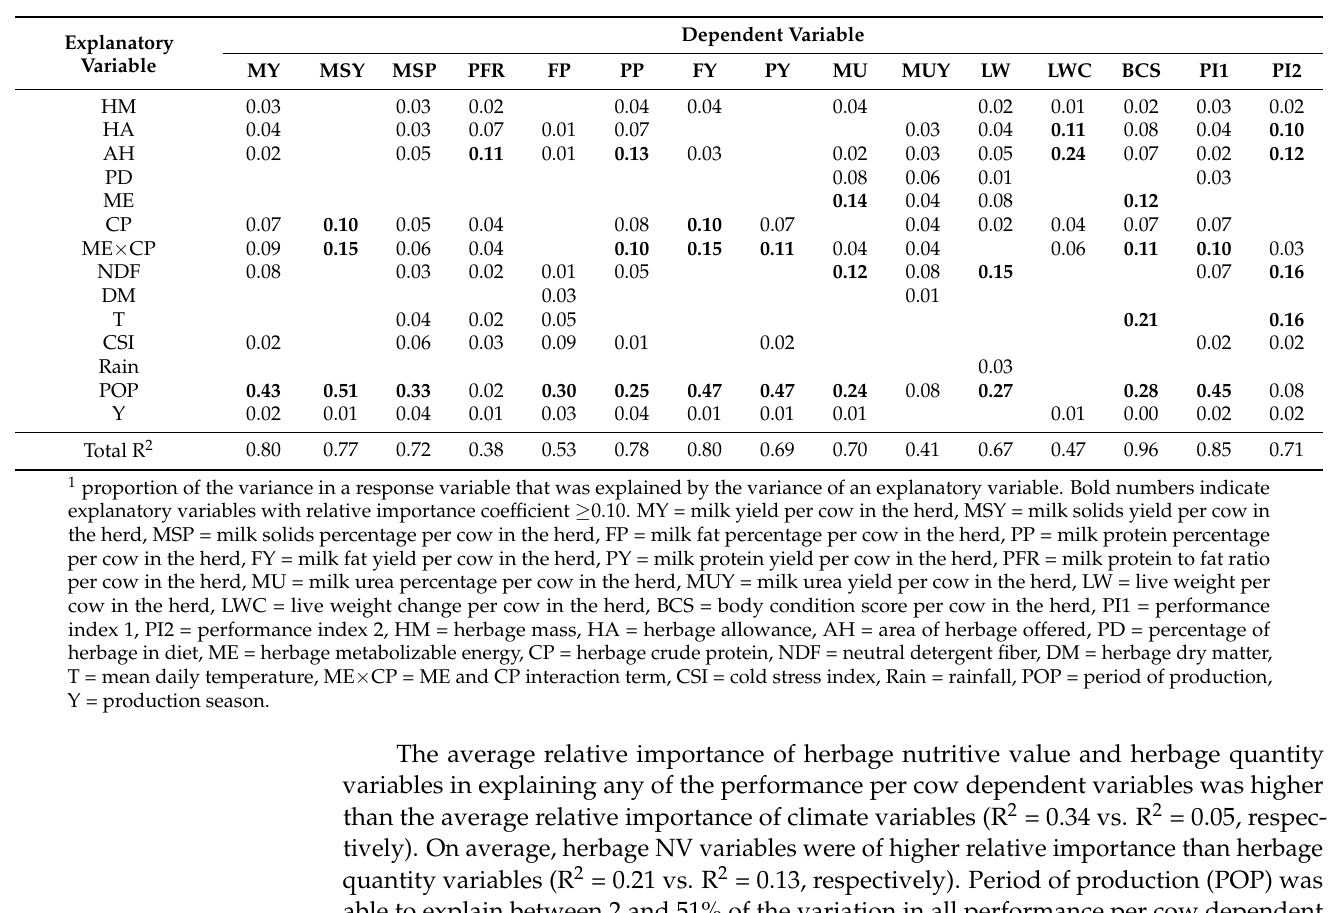
Table 4. Relative importance 1 of herbage nutritive value, herbage quantity and climate variables in explaining responses in performance per